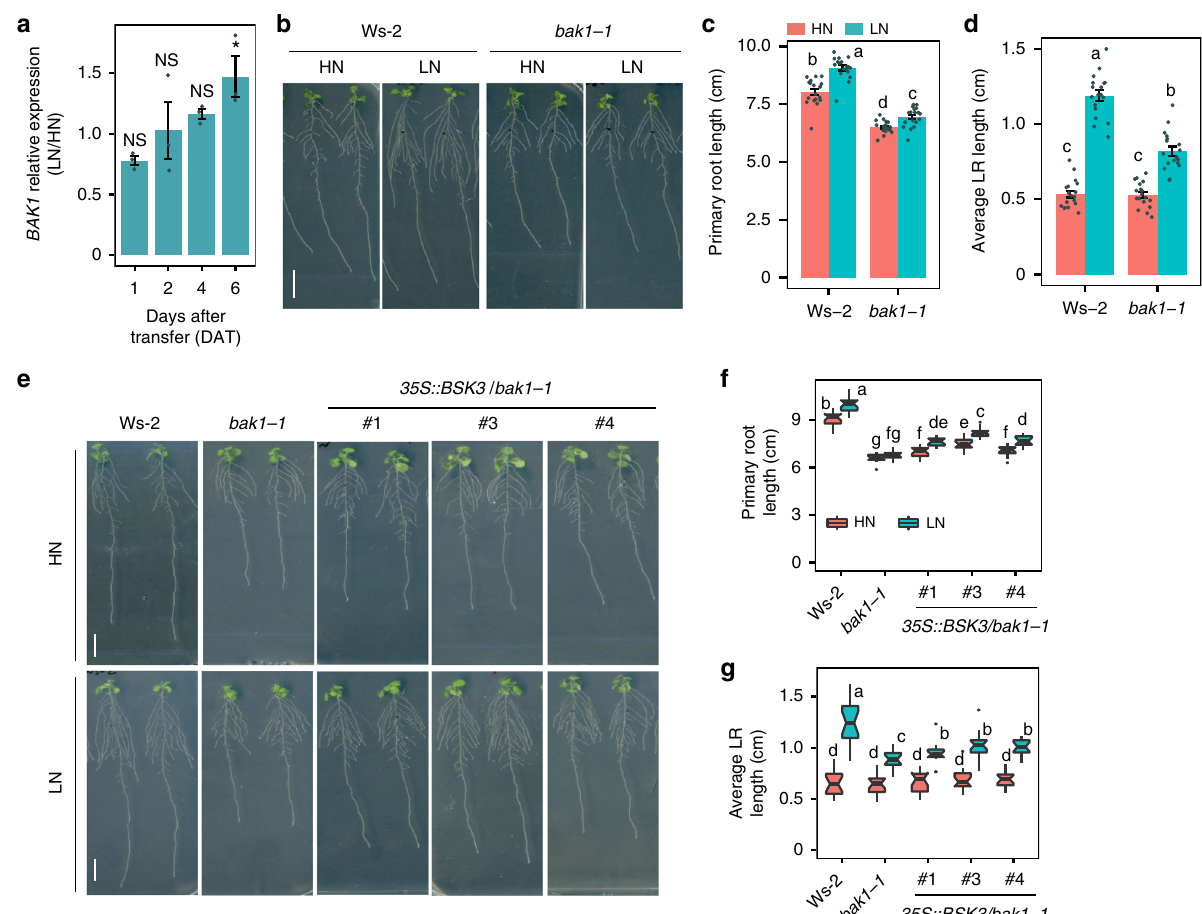
Fig. 7 Transcriptional regulation of BAK1 and overexpression of BSK3 in bak1-1 . a Fold change of BAK1 transcript levels in roots during growth on low N. BAK1 transcript levels were assessed in whole roots by qPCR analysis and normalized to ACT2 and UBQ10 . Bars represent means± SEM ( n = 3 independent biological replicates). Asterisks indicate signi fi cant differences to HN at each time point according to Welch ’ s t -test (* P < 0.05; NS, not signi fi cant). b – d Phenotypic analysis of bak1-1 mutant plants. Appearance of plants ( b ), primary root length ( c ), average lateral root length ( d ) of wild-type (Ws-2) and bak1-1 plants grown under HN or LN. Bars represent means ± SEM ( n = 18 independent biological replicates). e – g Phenotypic analysis of bak1-1 mutant and BSK3 overexpression lines. Appearance of plants ( e ), primary root length ( f ), and average lateral root length ( g ) of HN- and LN-grown wild type (Ws-2), bak1-1 , and three independent T2 transgenic lines overexpressing BSK3 in bak1-1 . Root system architecture was assessed after 9 days ( n = 16 independent biological replicates). Horizontal lines show medians; box limits indicate the 25th and 75th percentiles; whiskers extend to 5th and 95th percentiles. Different letters indicate signi fi cant differences at P < 0.05 according to one-way ANOVA and post-hoc Tukey ’ s test. Scale bars, 1